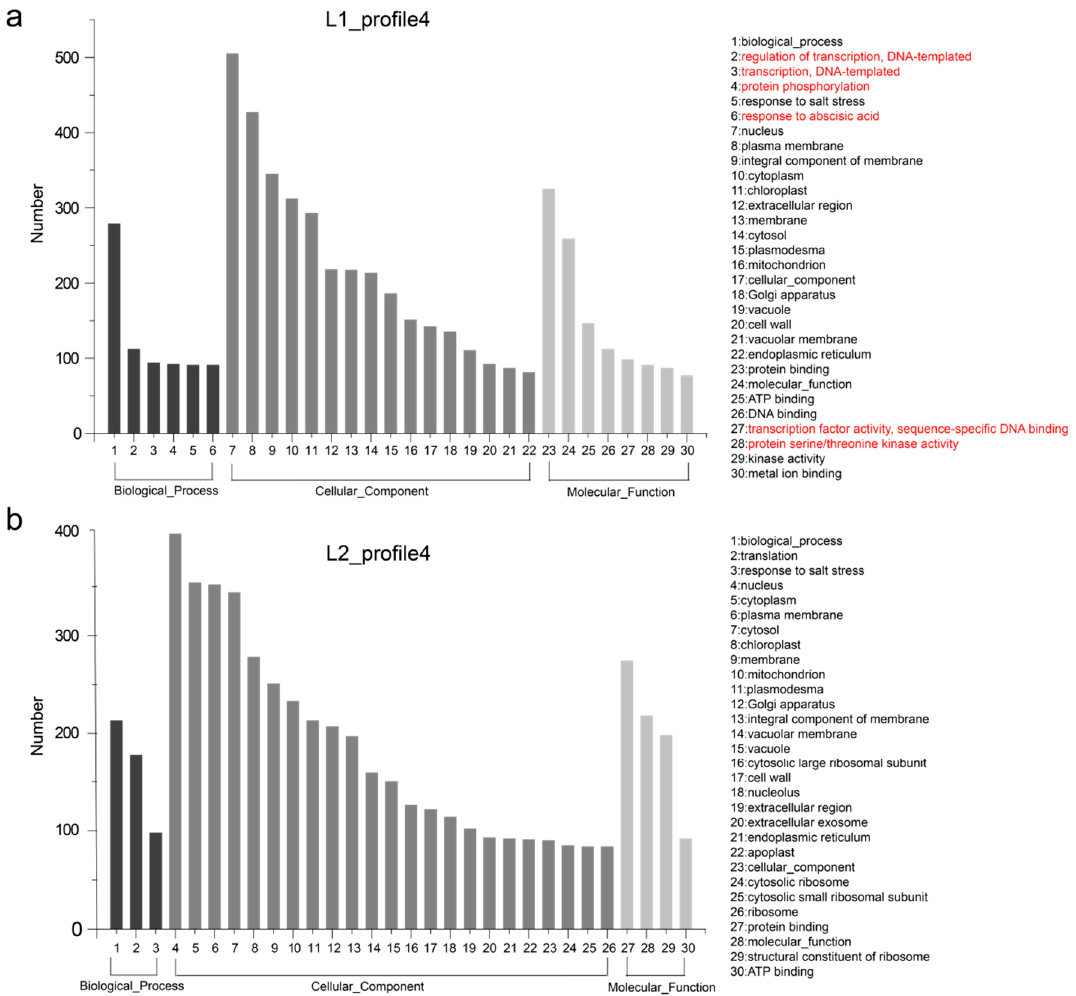
Figure 4. Gene ontology (GO) enrichment of genes listed in expression profile 4. ( a ) and ( b ) show the top 30 terms of GO enrichment for 1112 and 1060 genes unique to L1 and L2, respectively. The main different terms are highlighted in red.